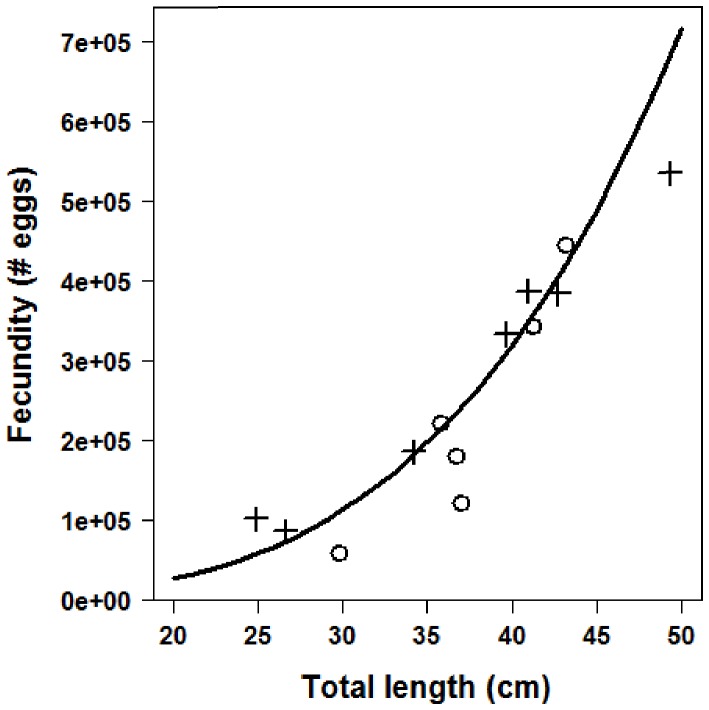
Weight at length for grass rockfish (Sebastes rastrelliger) in the Santa Barbara Channel, CA, USA.Solid line represents the fit to data from the high productivity subregion (circles); dashed line represents the fit to data from the low productivity subregion (triangles). Inset depicts log transformed length and weight outputs that were used for hypothesis testing.